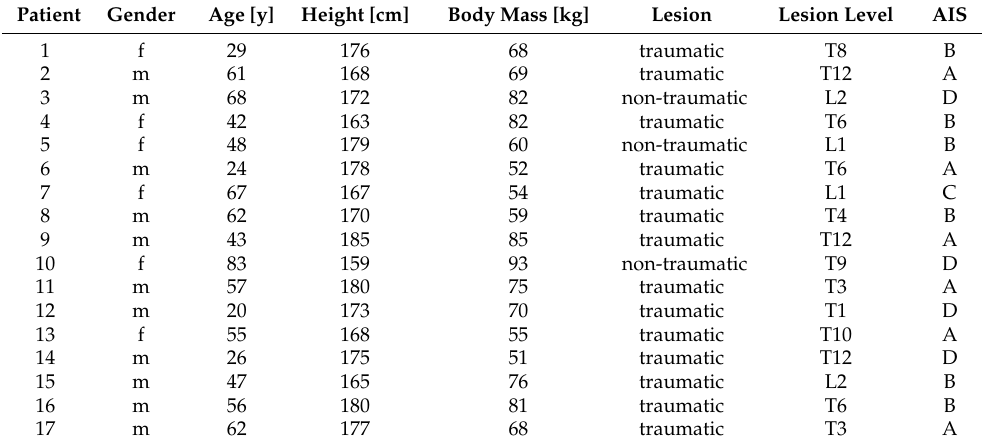
Table 1. Characteristics of study participants included at the start of the study ( n = 17).